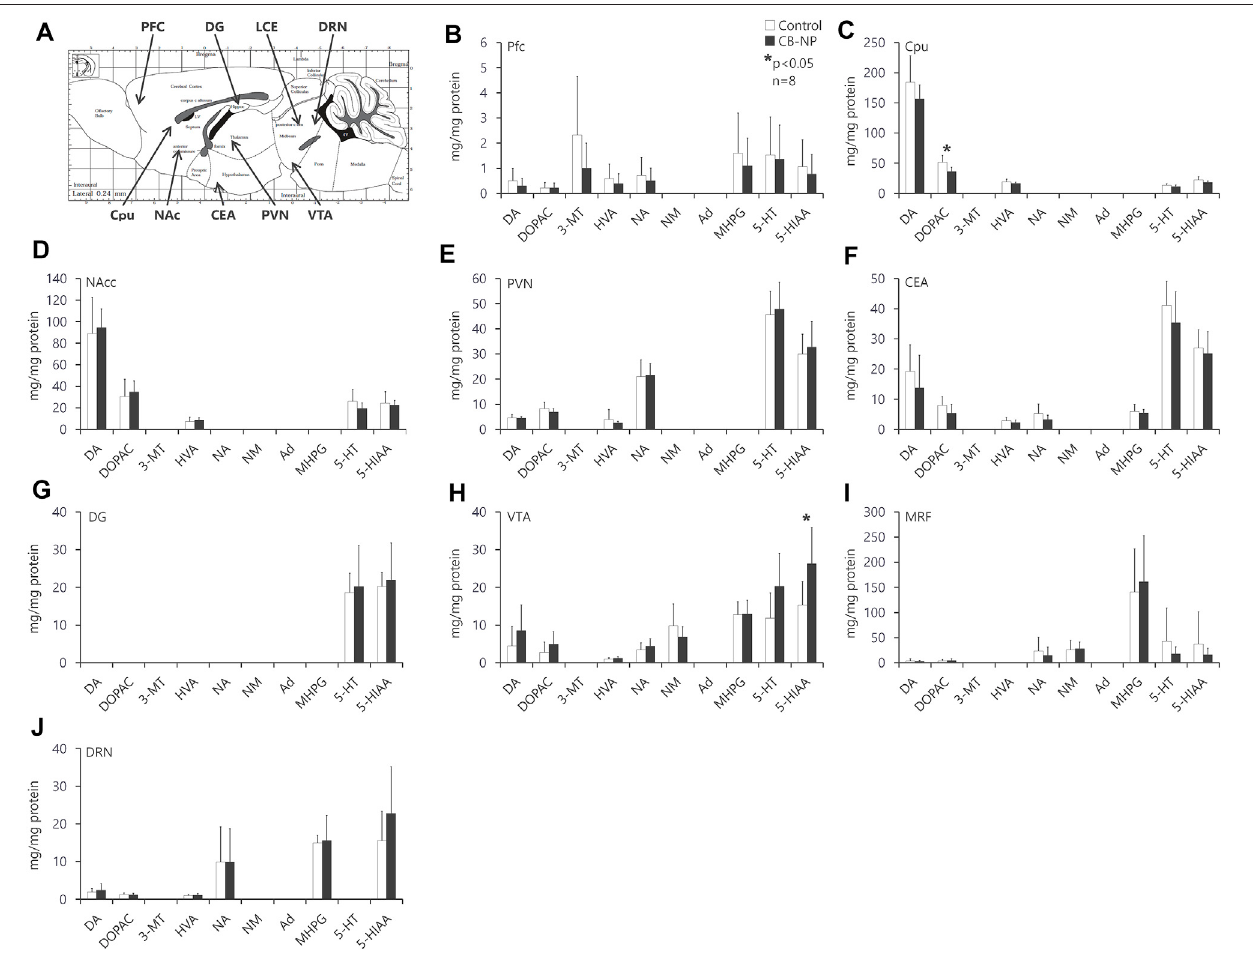
FIGURE 6 | Levels of each neurotransmitter and their metabolite in each brain region. The effect of maternal carbon black nanoparticle exposure on each neurotransmitter and its metabolite in each brain region was evaluated. (A) Evaluated brain regions in mice offspring. The image indicates the sagittal section. (B – J) Amount of dopamine (DA), noradrenaline (norepinephrine, NA), adrenaline (epinephrine, Ad), serotonin (5-Hydroxytryptamine, 5-HT), 3,4-dihydroxyphenylacetic acid (DOPAC), 3-methoxytyramine (3-MT), homovanillic acid (HVA), normetanephrin (NM), 3-Methoxy-4-hydroxyphenylglycol (MHPG), and 5-hydroxyindole-3-acetic acid (5-HIAA)in theprefrontal cortex (PFC), nucleus accumbens (NAcc), paraventricularhypothalamic nucleus (PVN), ventral tegmental area(VTA), dorsal raphenucleus (DRN), caudate-putamen/neostriatum (Cpu), central nucleus of amygdala (CEA), and medullary reticular formation (MRF), respectively. Values are expressed as the mean ± standard deviation. n = 8. The white column indicates the control group and the black column indicates the carbon black nanoparticle exposure group.